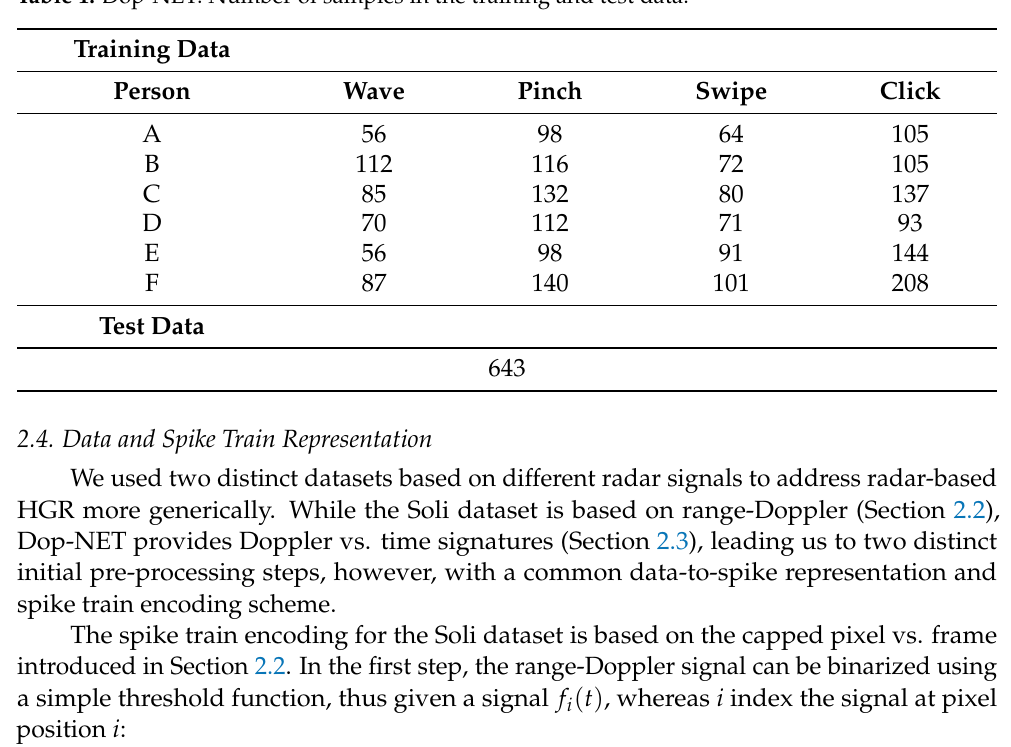
Figure 7. Dop-NET: Micro-Doppler time vs. frequency spectrograms of the 4 gestures (Wave, Pinch, Swipe and Click). Table 1. Dop-NET: Number of samples in the training and test